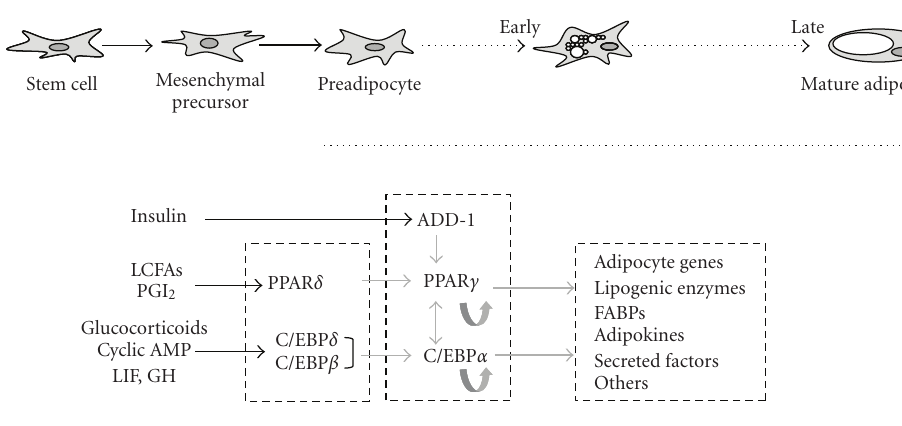
Figure 1: Adipocyte di ff erentiation (adipogenesis) and transcriptional events in adipogenesis. A pluripotent stem cell precursor gives rise to a multipotential mesenchymal precursor cell with a potential to di ff erentiate into an adipocyte. The preadipocyte enters the adipogenesis stage via environmental and gene expression signals. In an early stage of adipogenesis, major transcriptional factors such as PPAR γ and C/EBP α are expressed, and these factors strongly regulate the expressions of adipogenesis-related genes. The adipocyte secretes various factors, including adipokines, and the secreted factors play an important role in glucose and lipid metabolism, immune system, appetite regulation, and vascular disease. LCFAs: long-chain fatty acids; PGI 2 : prostacyclin; LIF: leukemia inhibitory factor; GH: growth hormone; ADD-1: adipocyte determination and di ff erentiation factor-1; FABPs: fatty acid-binding